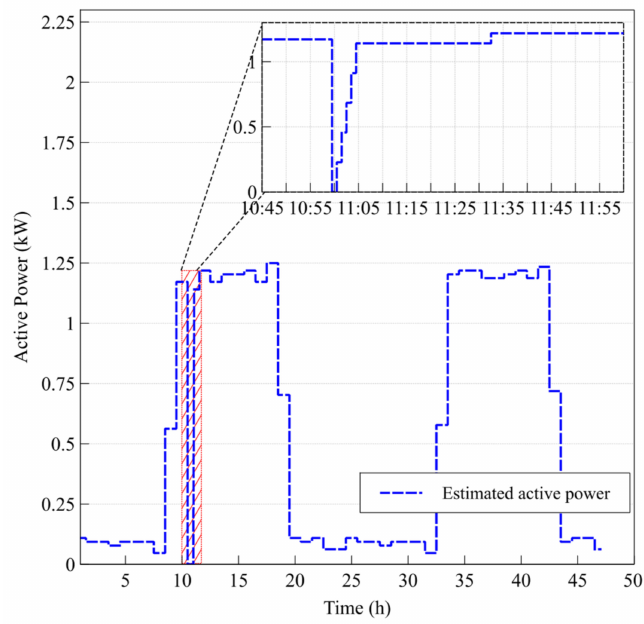
Figure 9. Power outage scenario and load recovery